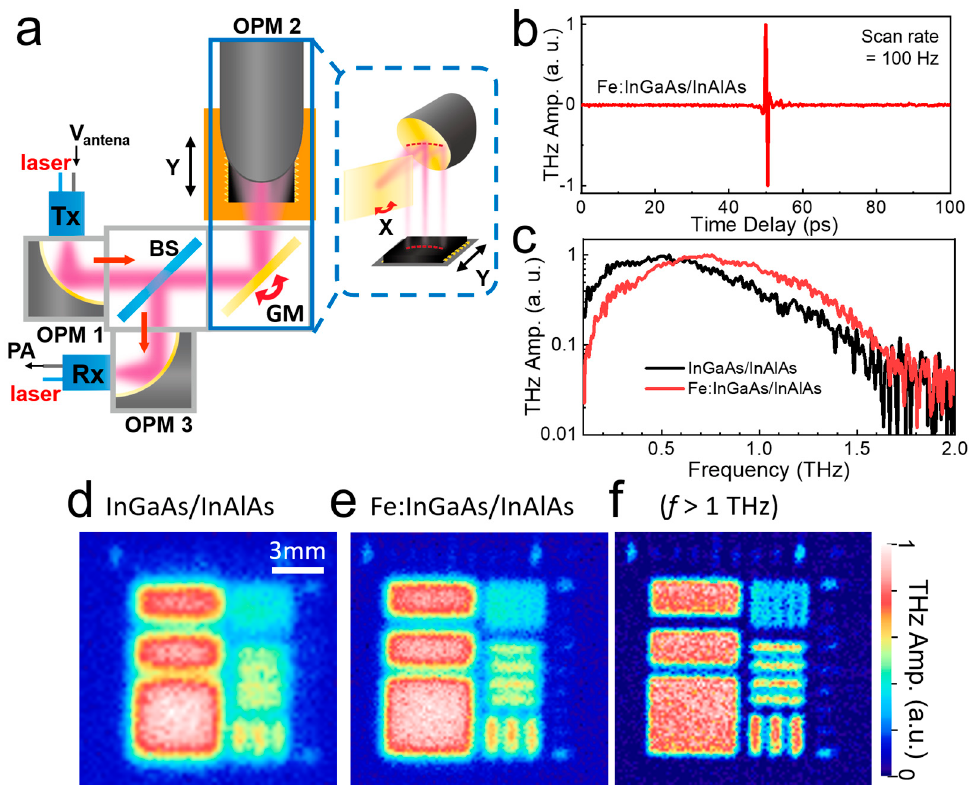
Figure 1. ( a ) Schematic illustration of the THz-TOF imaging setup with all-reflective optics. ( b ) A representative THz reflection amplitude as a function of time delay (A-scan). ( c ) THz reflection spectra for both antenna types ( c – e ) Time-integrated reflection amplitude images on a test pattern (C-scan) with old antenna ( d ), new antenna ( e ), and high-frequency filtered image with the new antenna ( f ). GM: galvanometer, BS: beamsplitter, OPM: off-axis parabolic mirror, PA: current preamplifier.